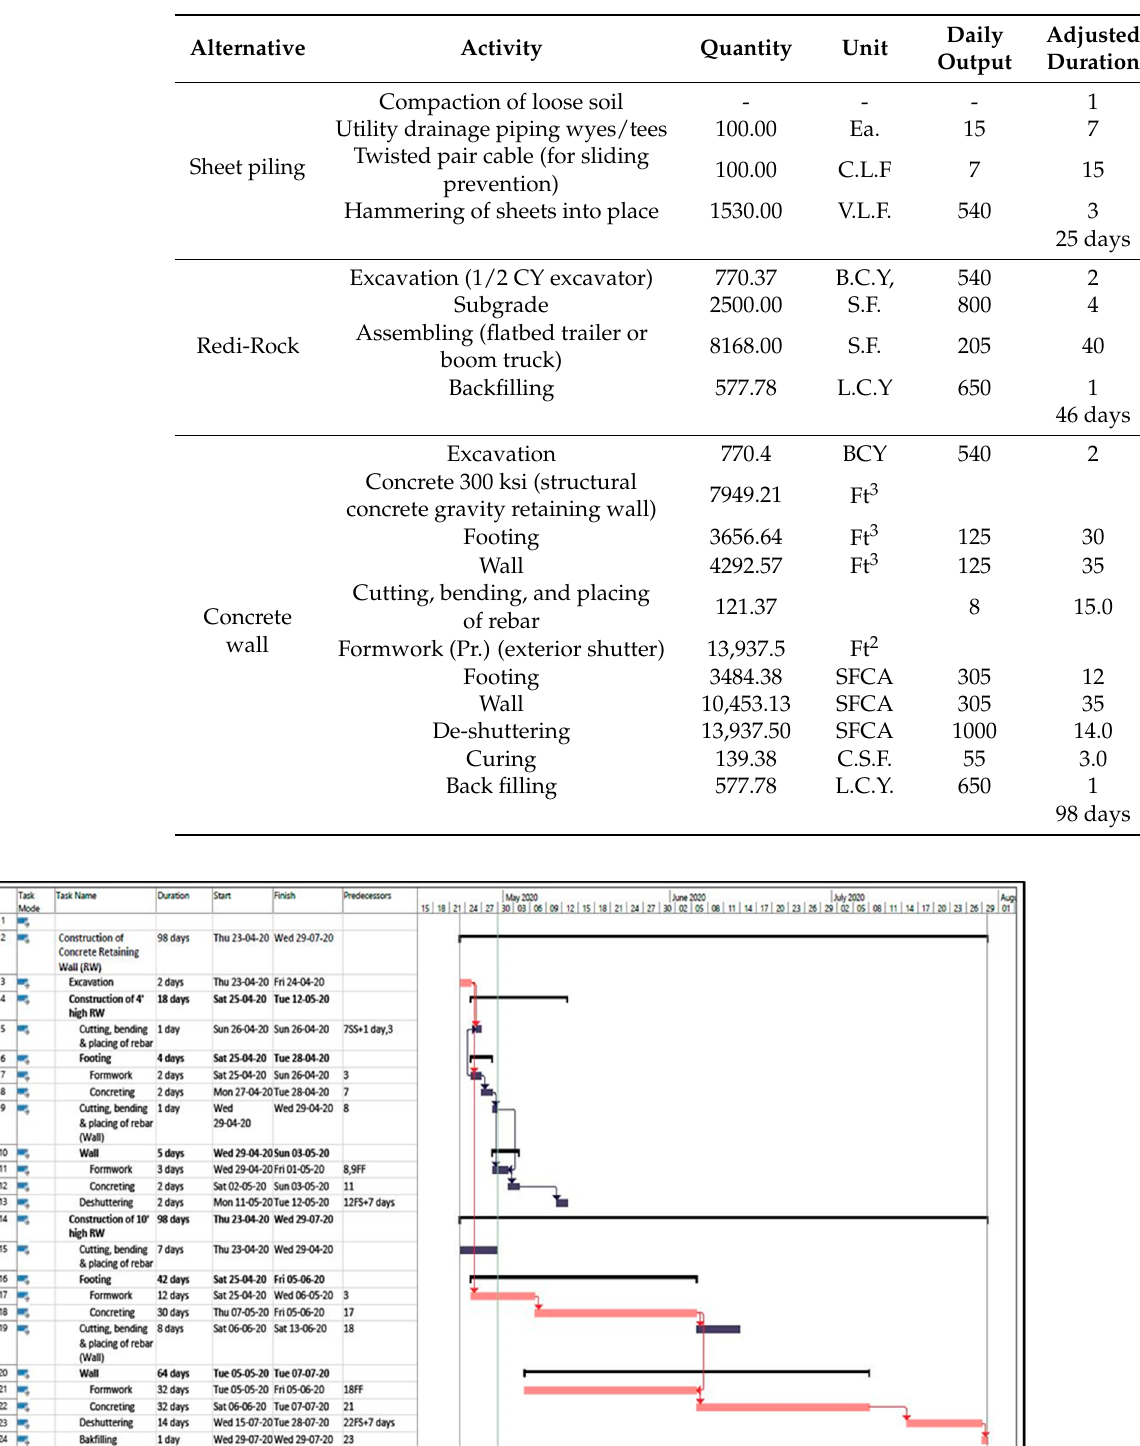
Table A1. The construction work and duration of the alternatives for retaining wall rehabilitation.